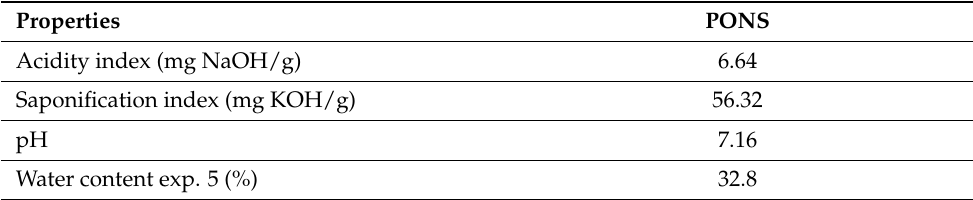
Table 4. Physicochemical characterization of palm oil neutralization sludge (soap phase residue